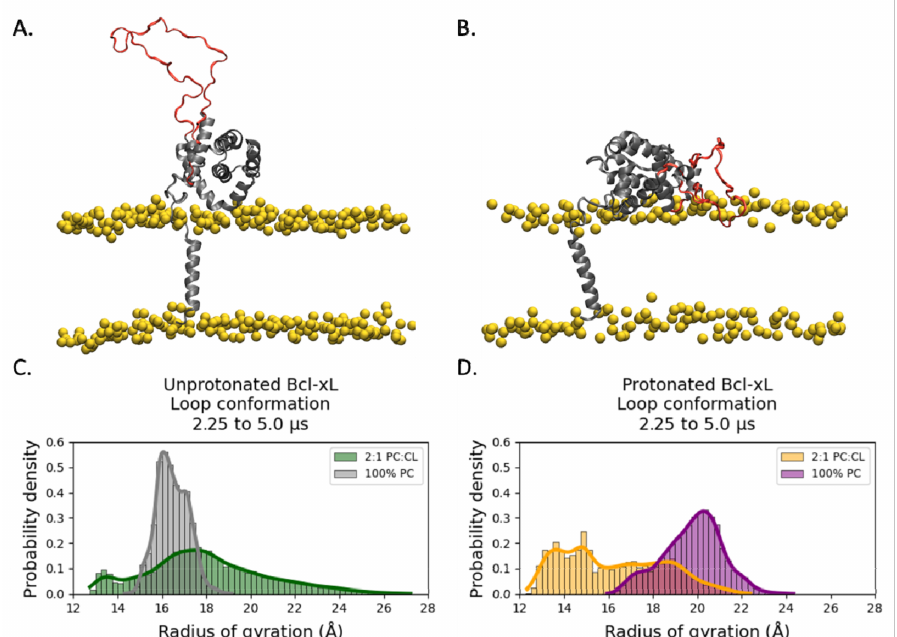
Figure 4. Conformation of the α 1- α 2 loop. ( A ) Configuration snapshot corresponding to an ex- tended loop conformation in the unprotonated POPC:TOCL system. ( B ) Configuration snapshot corresponding to a compact loop conformation in the protonated POPC:TOCL system. The protein is shown in secondary structure representation colored gray, except for the α 1- α 2 loop which is shown in red. The lipid phosphate phosphorus atoms are shown as yellow spheres. The rest of the simulation system has been removed for clarity. The α 1- α 2 loop radius of gyration is broadly distributed in the POPC:TOCL systems in comparison to POPC, suggesting that the presence of cardiolipin confers more flexibility to the loop. The comparison between the radius of gyration distributions in the unprotonated ( C ) and protonated ( D ) systems suggests that protonation of the Bcl-xL titratable residues promotes extended loop conformations in the POPC system and compact loop conformations in the POPC:TOCL